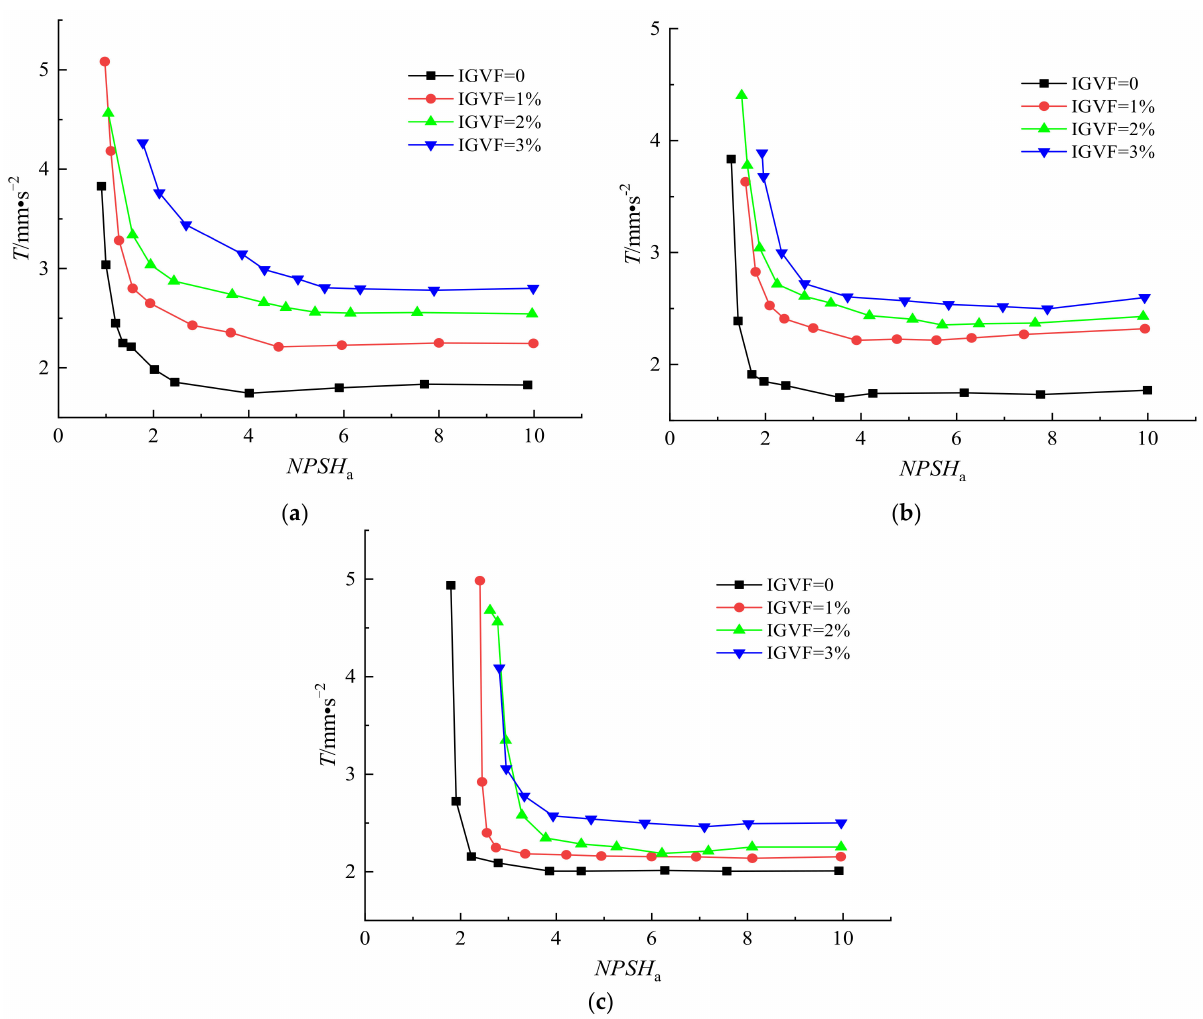
Figure 9. Vibration intensity of the model pump foot under different IGVF conditions and different flow rates: ( a ) 0.75 Q ld ( b ) 1.0 Q ld and ( c ) 1.25 Q ld